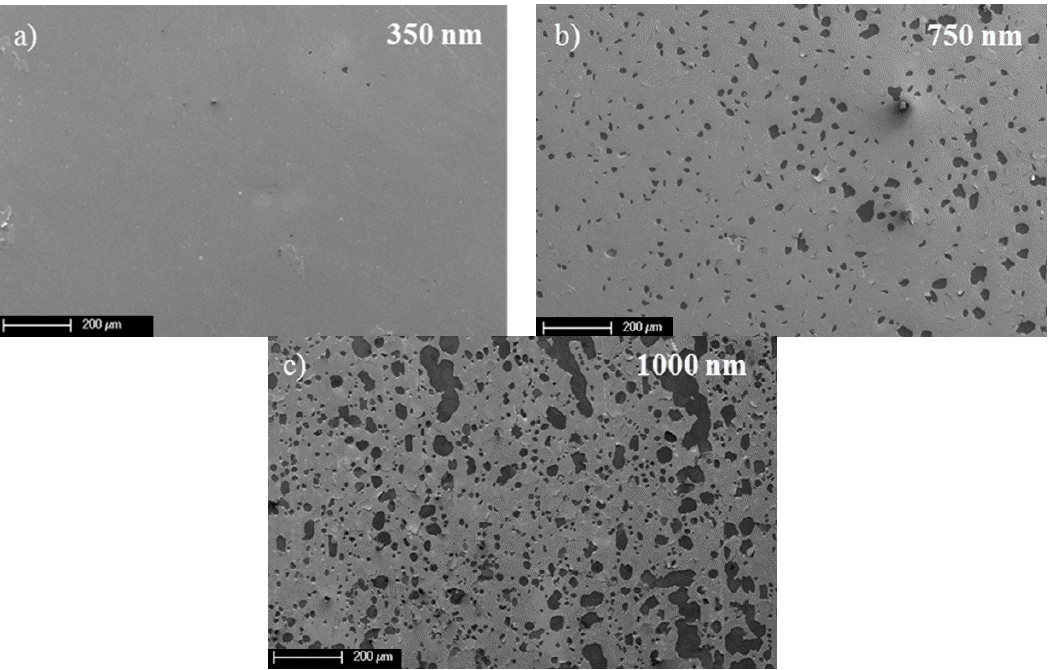
Figure 5. SEM observation after annealing at a temperature of 600 °C of a La 2 CuO 4 film with a thickness of ( a ) 350 nm, ( b ) 750 nm, and ( c ) 1000 nm .